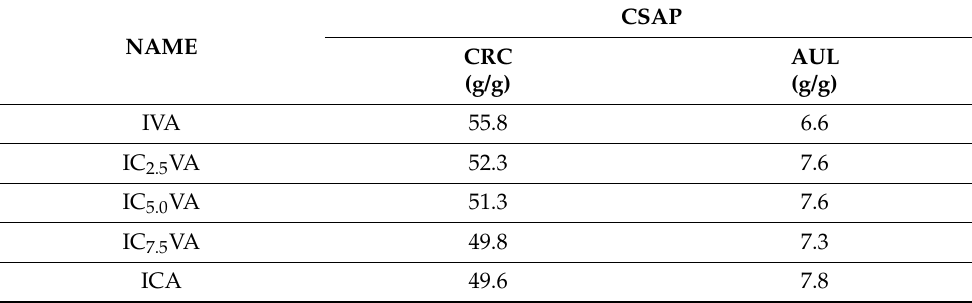
Table 3. The centrifuge retention capacity (CRC) and absorbency under load (AUL) of the CSAP according to the composition of monomer.